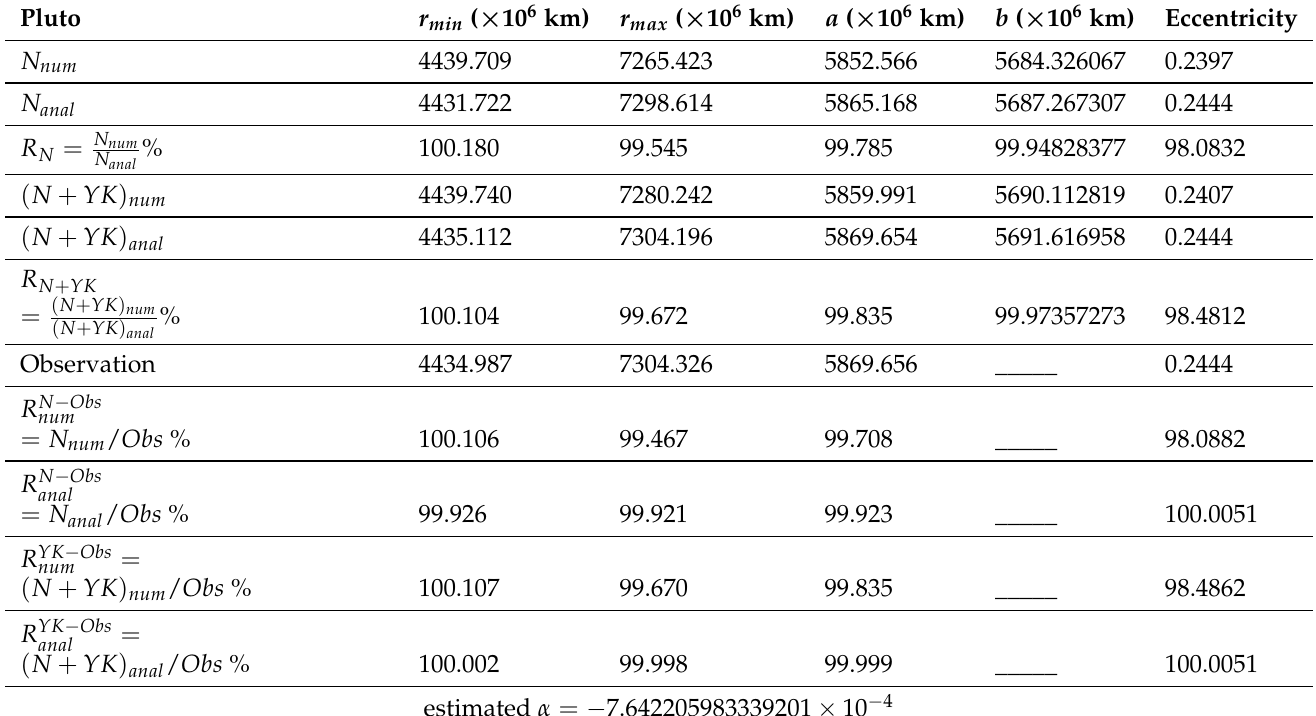
Table A18. The values of the calculated and observational astronomical parameters, for estimated α , of the planet Pluto, whose number of moons is 0.